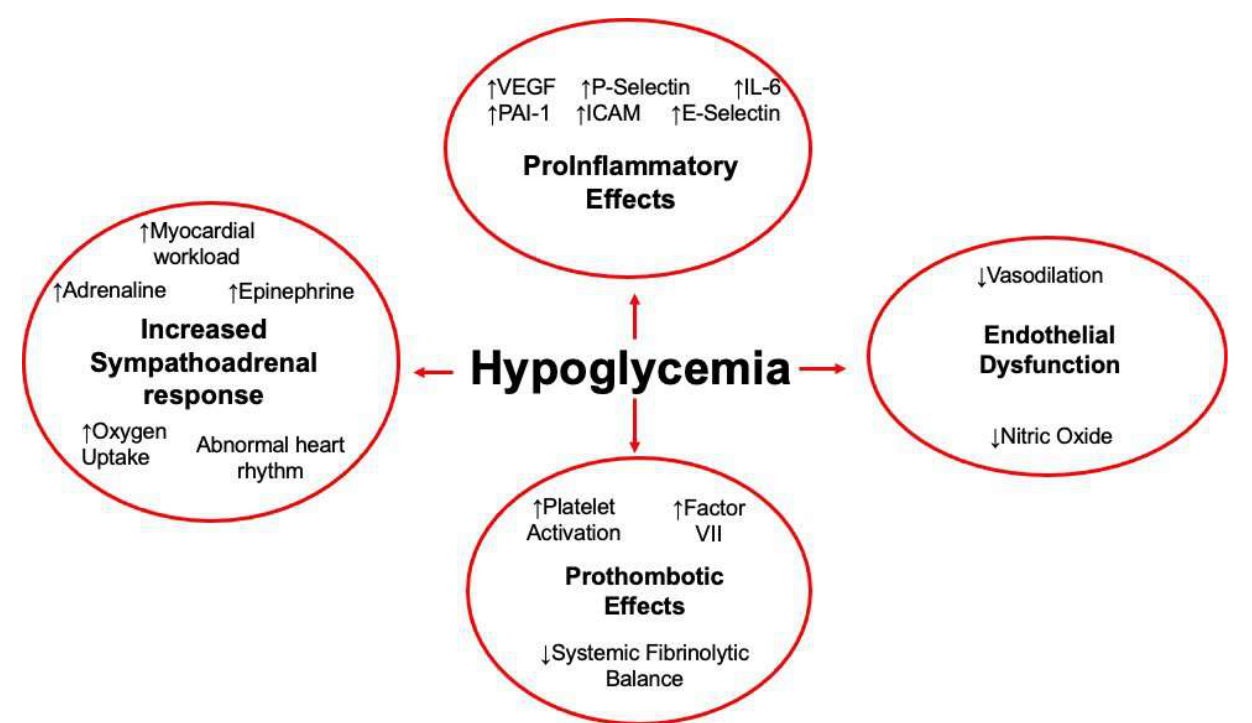
Figure 3. Mechanisms by which hypoglycemia may induce pathophysiological changes in the cardiovascular system.